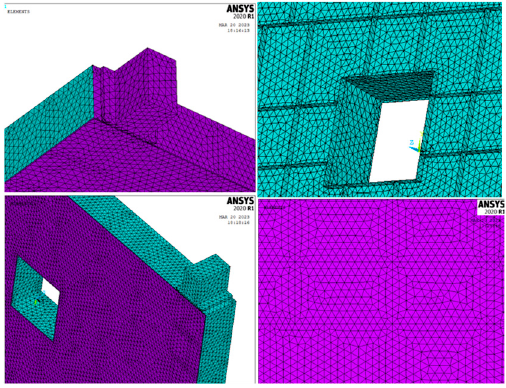
Figure 2. Large body structure finite element model.